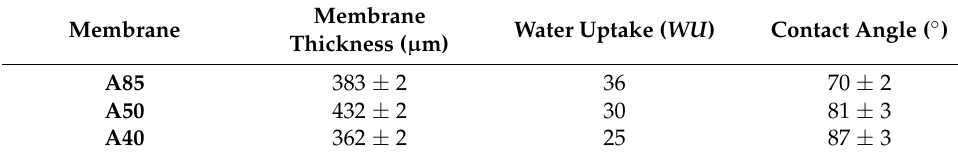
Table 3. Same physical properties of the composite membranes